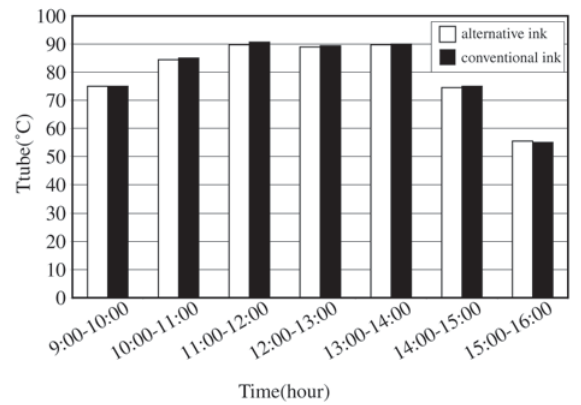
Figure 5 . External temperature of the painted tubes with different